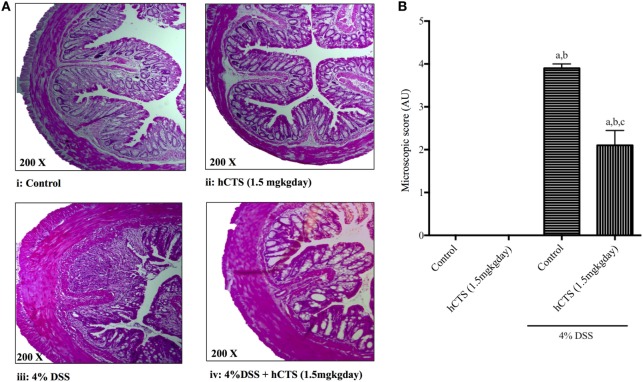
Effect of human catestatin (hCTS) treatment (1.5 mg/kg/day, i.r. 7 days) on (A) representative colonic architecture and (B) composite histological score. When compared to the colonic appearance of non-colitic mice [no hCTS, (A):i and with hCTS, (A):ii], dextran sulfate sodium (DSS) treatment (A):iii resulted in massive infiltration of immune cells and damage of intestinal architecture. This cell infiltration was inhibited together with improvement of tissue architecture in hCTS-treated DSS mice (A):iv. Thus, the composite histological (microscopic) score was significantly improved in hCTS-treated colitic mice compared with vehicle-treated colitic mice (B). AU, arbitrary units; aP < 0.05 compared to the Control (No DSS/No hCTS) group; bP < 0.05 compared to the hCTS (No DSS) group; cP < 0.05 compared to the DSS (No hCTS) group; Bonferroni, one-way ANOVA. Control (n = 5), hCTS (n = 5), 4% DSS (n = 10), 4% DSS + hCTS (n = 12).